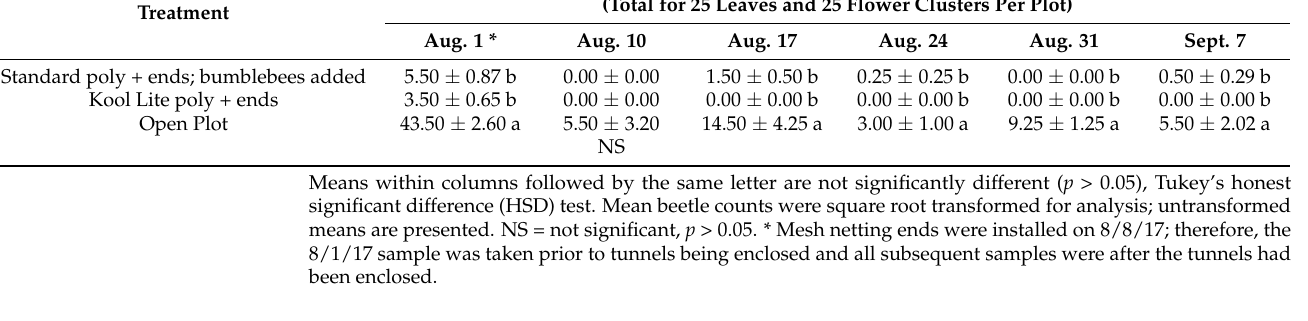
Table 2. Mean adult P. japonica counts in high tunnels covered with plastic and netting used for pest exclusion, ‘Heritage’ raspberry, Rosemount, MN,